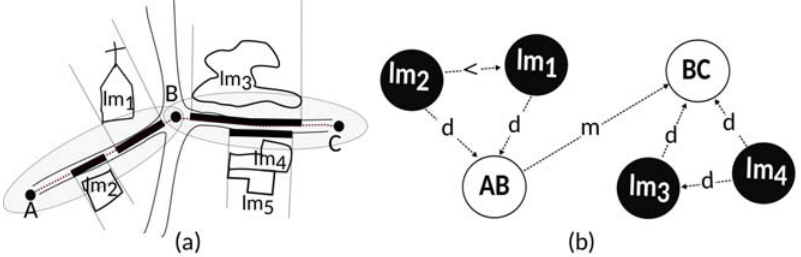
Figure 4: (a) The drawn objects in a sketch map, (b) the linear ordering of adjacent land- marks along the street segments (AB, BC) using the coarse IA